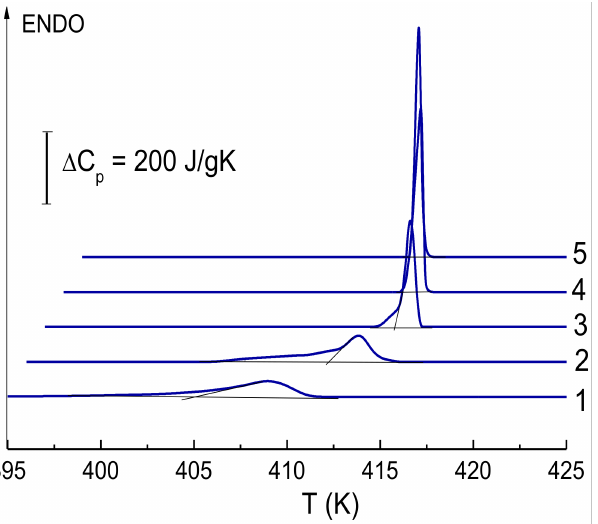
Figure 10. DSC curves obtained at a heating rate of V = 5 K/min for samples: 1—initial xerogel film (vaseline oil); 2— λ = 9; 3— λ = 43; 4— λ = 95; 5— λ =